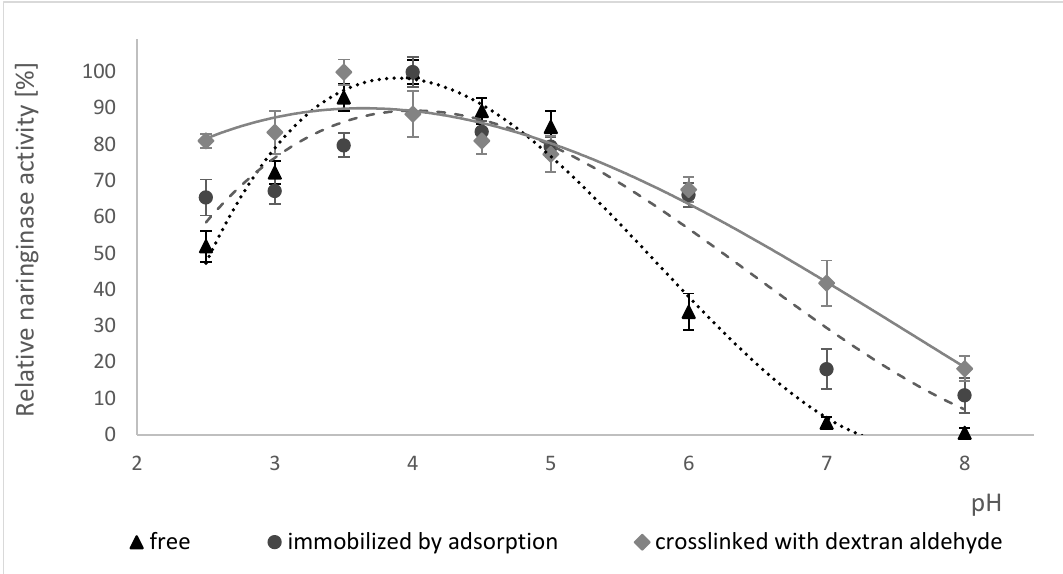
Figure 3. Effect of pH on the activity of free, immobilized and crosslinked naringinase from A. niger KMS. Activity of free naringinase (100% = 878 µmol min −1 g −1 of the preparation); Activity of naringinase immobilized by adsorption (100% = 17.04 µmol min −1 g −1 of the carrier); Activity of naringinse crosslinked with dextran aldehyde (100% = 19.29 µmol min −1 g −1 of the carrier). The activity of enzymes was determined at 50 °C, at the pH range 2.5–8.